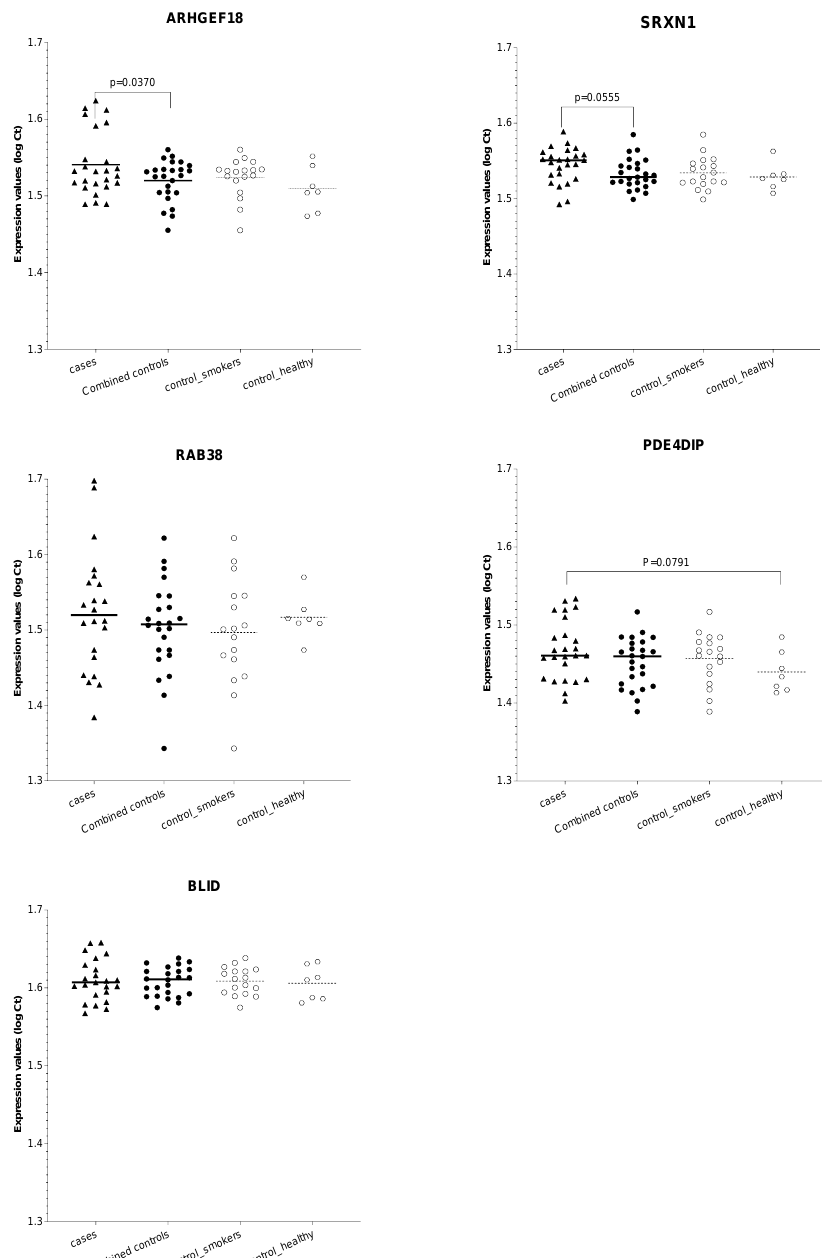
Figure 4. qRT-PCR analysis of changes in the expression levels of cfRNA of selective protein-coding genes in an independent sample. Each symbol represents log transformed Ct values of mRNA levels within each sample averaged across three technical repeats. The horizontal lines represent mean expression levels within each